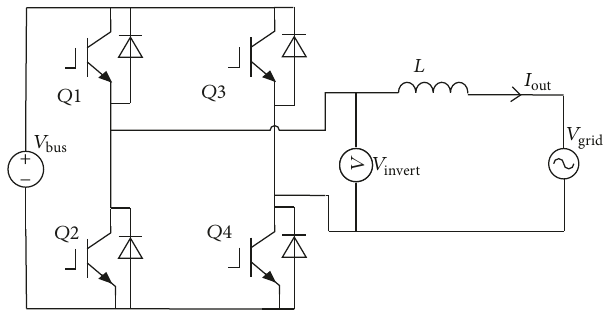
Figure 5: Schematic of poststage grid-connected inverter